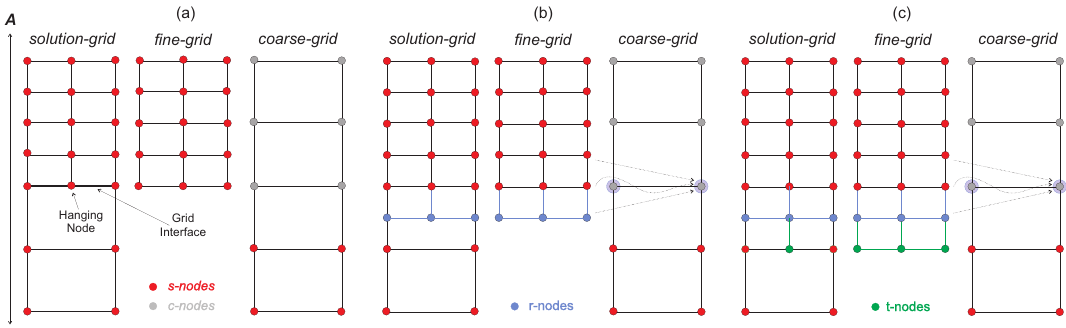
Fig. 3. (a) The problem: one coarse-grid element interfacing with two fine-grid elements. The location of genuine unknowns (i.e. unknowns that are associated with an approximation to the governing differential equation), s nodes, is shown for both fine and coarse grids. (b) The problem, modified to show the r nodes which are introduced for computational convenience. These nodes are not unknowns in our system of equations, but dummy nodes that are introduced to allow consistent solution derivation at all genuine nodes. With just one boundary layer (the r nodes), fine-grid solution continuity will not be satisfied during inter-grid projection: the r nodes would act as boundary values during fine-grid calculations and would not be updated. Consequently, the values projected from the fine-grid to the encircled c nodes (coarse grid nodes utilized during the multigrid process that do not explicitly contribute to the final solution), during the multigrid solution process, would be derived from nodal solutions with both fine and coarse-grid accuracy. Accordingly, a second layer of dummy nodes, the t nodes, are introduced, as illustrated in part (c) . Their inclusion and the subsequent updating of r nodes during fine-grid calculations, ensures solution continuity during inter-grid projection. In summary, s nodes are the genuine nodes, intrinsic to the final solution. r and t nodes are utilized during fine-grid calculations and inter-grid projection, whilst c nodes represent coarse-grid nodes, that are integral to the overall multigrid process, but do not explicitly contribute to the final